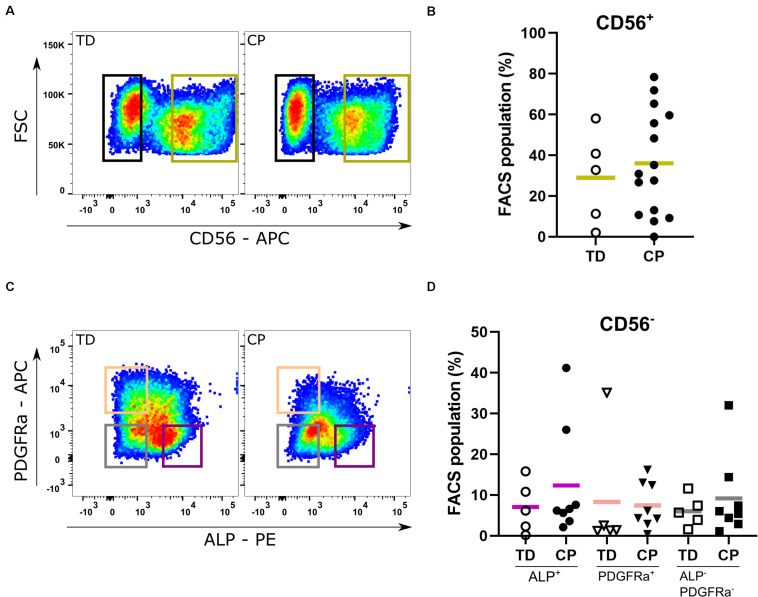
Fluorescent Activated Cell Sorting of muscle stem cells. (A) Example of Fluorescent Activated Cell Sorting (FACS): based on the expression of CD56, satellite cell-derived progenitors (SCs; green gate) were isolated from both TD children (n = 5) as well as patients with CP (n = 15). (B) Percentages of CD56+ cells from each child are reported in the graph. (C) Example of FACS: after amplification, FACS on the CD56– population isolated mesoangioblasts (MABs; CD56– PDGFRa– ALP+; purple gate), fibro-adipogenic progenitors (FAPs; CD56– ALP– PDGFRa+; orange gate) and interstitial cells (ICs; CD56– ALP– PDGFRa–; gray gate) (TD: n = 5; CP: n = 8). (D) Percentages of CD56– PDGFRa– ALP+ (circles), of CD56– ALP– PDGFRa+ (triangles) and CD56– ALP– PDGFRa– (squares) cells from each patient are reported in the graph. Statistics were performed by unpaired two-tailed T-test (p > 0.05) for isolation of the CD56+ population and one-way ANOVA was performed to assess the MAB, FAP, and IC fractions. Means are indicated per group by a horizontal line.